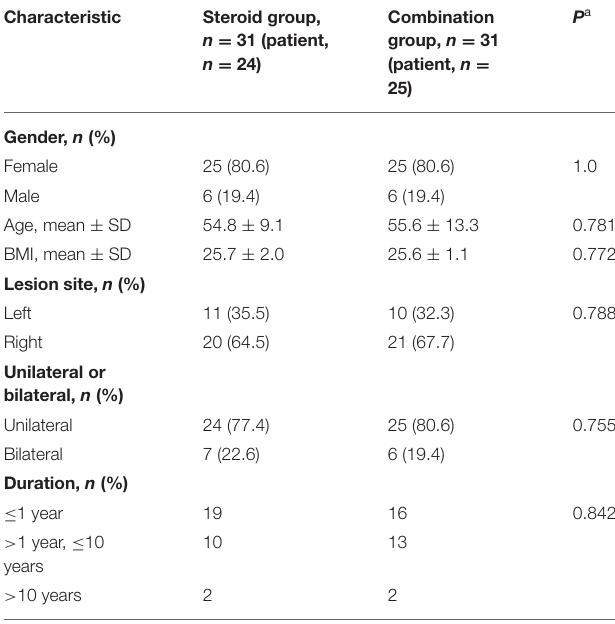
TABLE 1 | Baseline demographic and clinical characteristics of